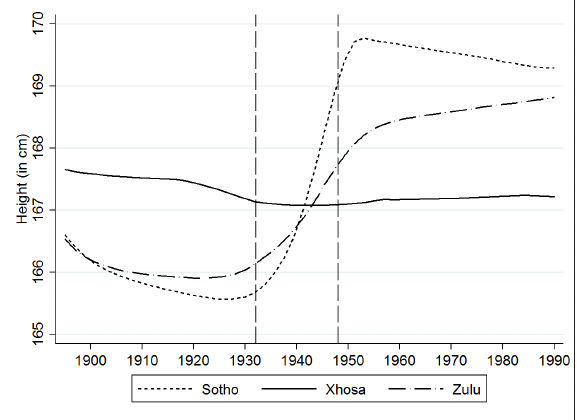
Figure 5: Height of black men by ethnicity, 1895–1990. Figure 5 clearly shows that the three ethnicities experienced different patterns of change over the century. Heights of Xhosa men changed